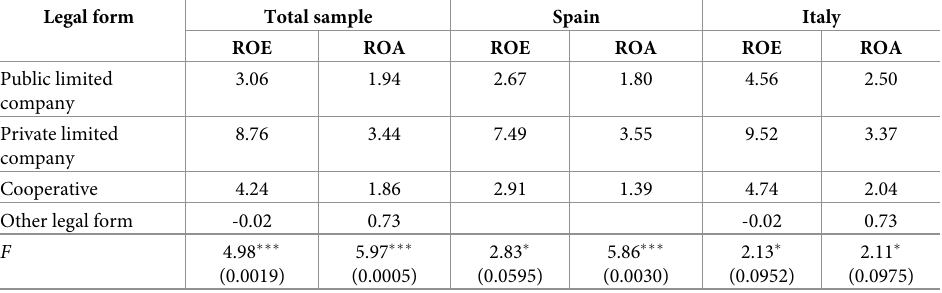
p -value in brackets. ��� , �� and � denote a significance level below 1%, 5% and 10%, respectively. Source: Own